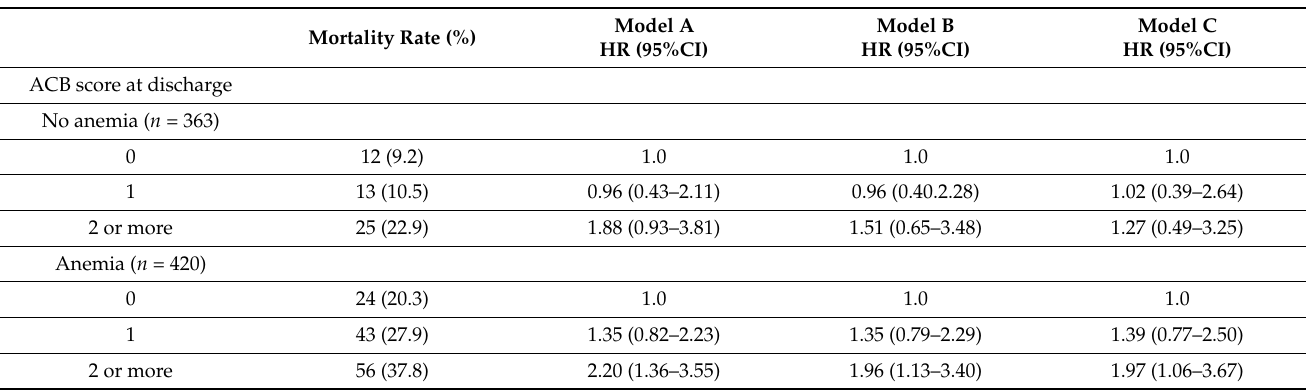
Figure 1. Kaplan Meier curves showing survival associated with ACB score and anemia. Table 4. Cox proportional hazard models of the relationship between ACB score at discharge and 1 year mortality stratified by the presence of